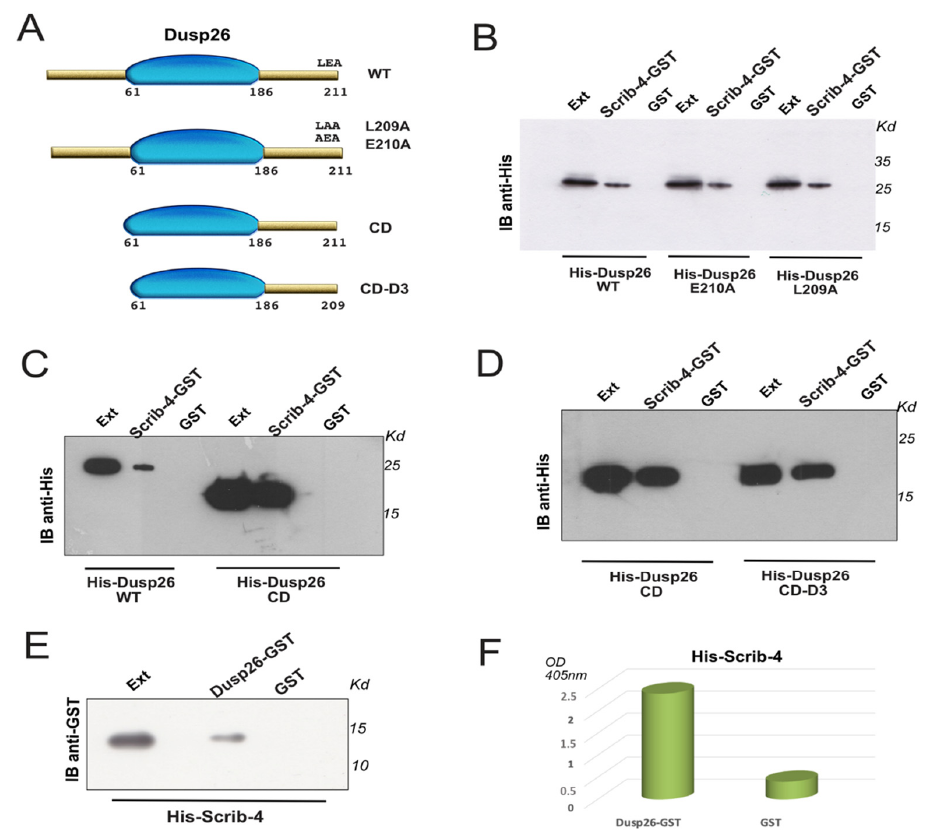
Figure 1. Dusp26 amino-terminus and carboxy-terminus are not indispensable to bind to Scribble PDZ-4. ( A ) Schematic representation of Dusp26 constructs. The phosphatase Dusp26 is a small protein of 211 amino acids constituting an N-terminal region of 60 amino acids, a catalytic domain (aa 61–186), and a short carboxyterminal region (187–211). ( B ) His-Dusp26 E210A and L209A mutants maintain the capability to recognize Scrib-4 in pull-down assays. Scrib-4 fused to GST was used as a bait and anti-His immunoblot revealed the bound phosphatase. Ext lane shows the input extracts, and GST alone was used as a control. ( C ) In a pull-down assay, performed as in (B), the CD mutant (aa 60–210) binds to Scrib-4-GST. ( D ) The CD mutant, lacking the 3 carboxyl-terminal amino-acids, still binds to Scrib-4-GST. ( E ) Pull-down assay with Dusp26 fused to GST used as a bait and Scrib-4 fused to His-tag. Anti-GST immunoblot revealed the bound domain. ( F ) ELISA test with Dusp26-GST-coated plates incubated with His-Scrib-4. The bound protein was detected by the anti-His